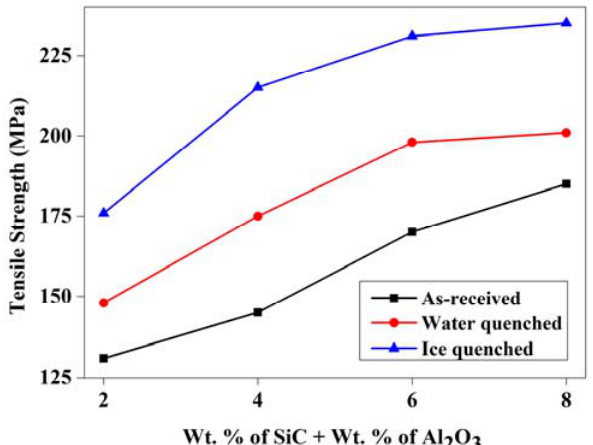
Figure 1: Tensile strength for varying wt. % of SiC and Al 2 O 3